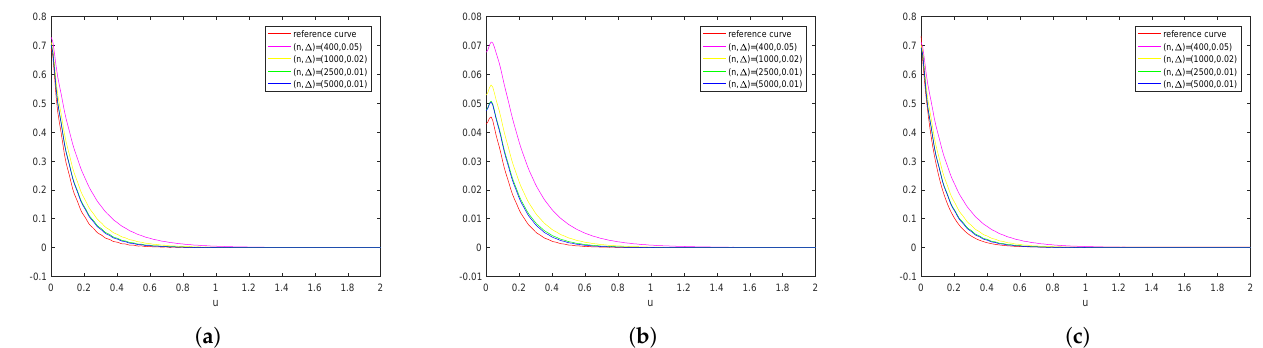
Figure 5. For the Lévy-Gamma risk model, we estimate the Gerber–Shiu functions by mean value curves. ( a ) Ruin probability; ( b ) Expected claim size causing ruin; ( c ) Laplace transform of ruin time.